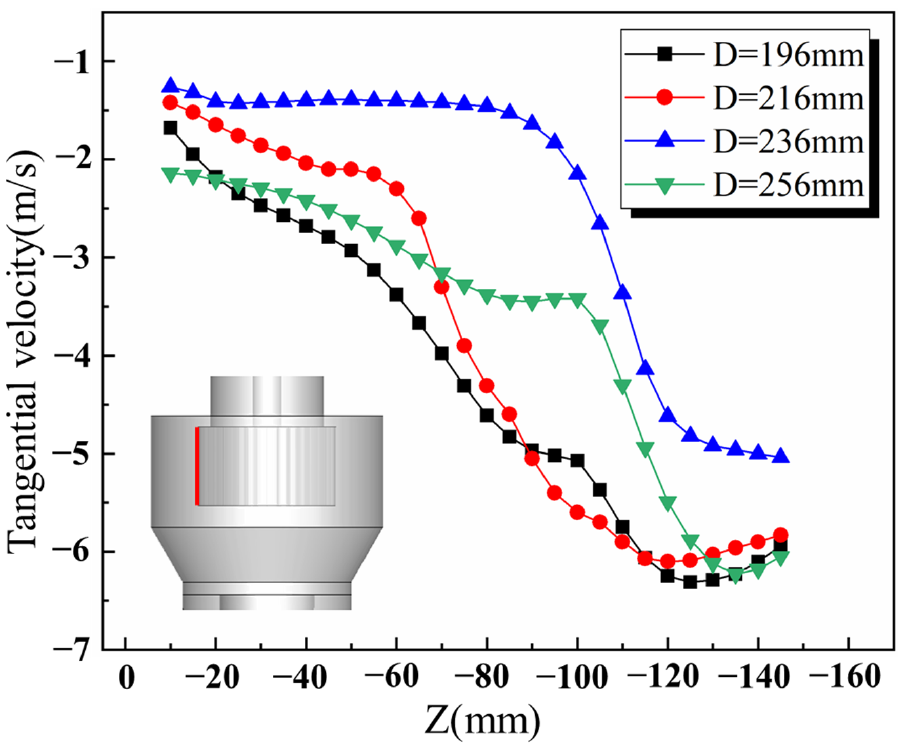
Figure 16. Effect of the guide cone diameter on the tangential velocity of the rotor cage entrance.